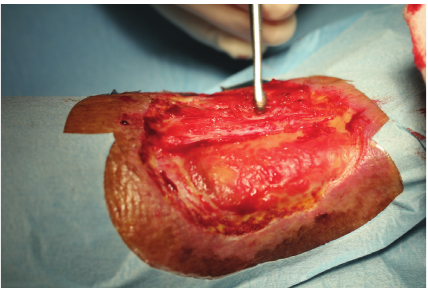
Figure 1: Right ankle: the ulcer was prepared by removing fibrin with a curette and the edges of the ulcer were freshened.